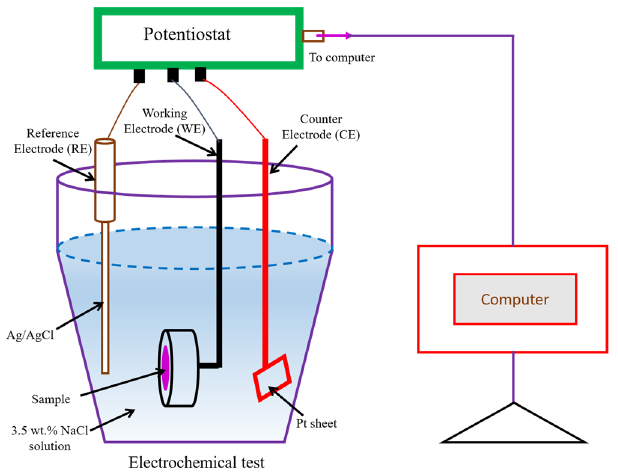
Figure 2. Schematic diagram representing electrochemical test on the developed ODS-HECs sam- ples .